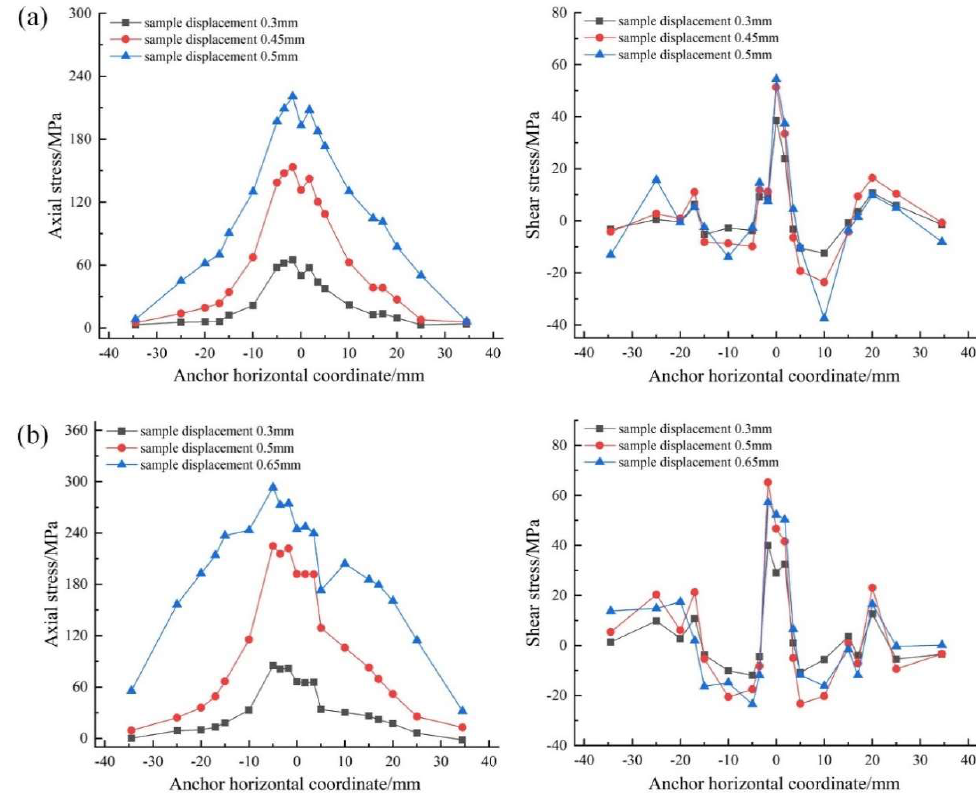
Figure 21. Axial and shear stress distribution for anchor: ( a ) F−45 sample; ( b ) R−45 sample.